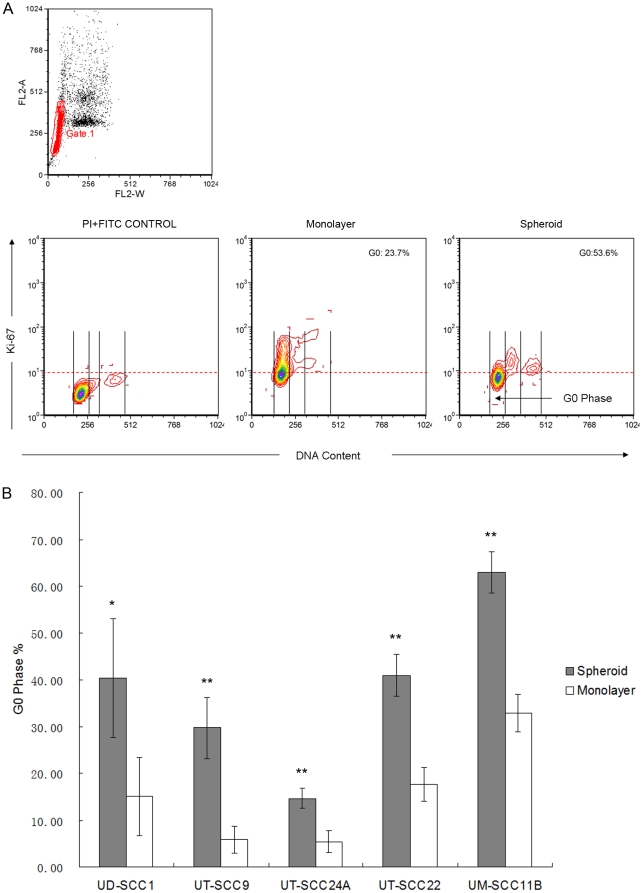
Cell cycle analysis of SDC and monolayer-derived cells by FACS analysis.(A) Double staining with Ki-67 and propidium iodide for the measurement of proliferation and cellular DNA content. Single cells were gated on FL2-W and FL2-A. DNA content and Ki-67 expression was evaluated by flow cytometry analysis. (B) Frequencies of quiescent cells in SDC as comparison to monolayer-derived cells. In all cases, the cells derived from spheroids contain a highly significant larger percentage of quiescent (G0) cells. (** p<0.01).